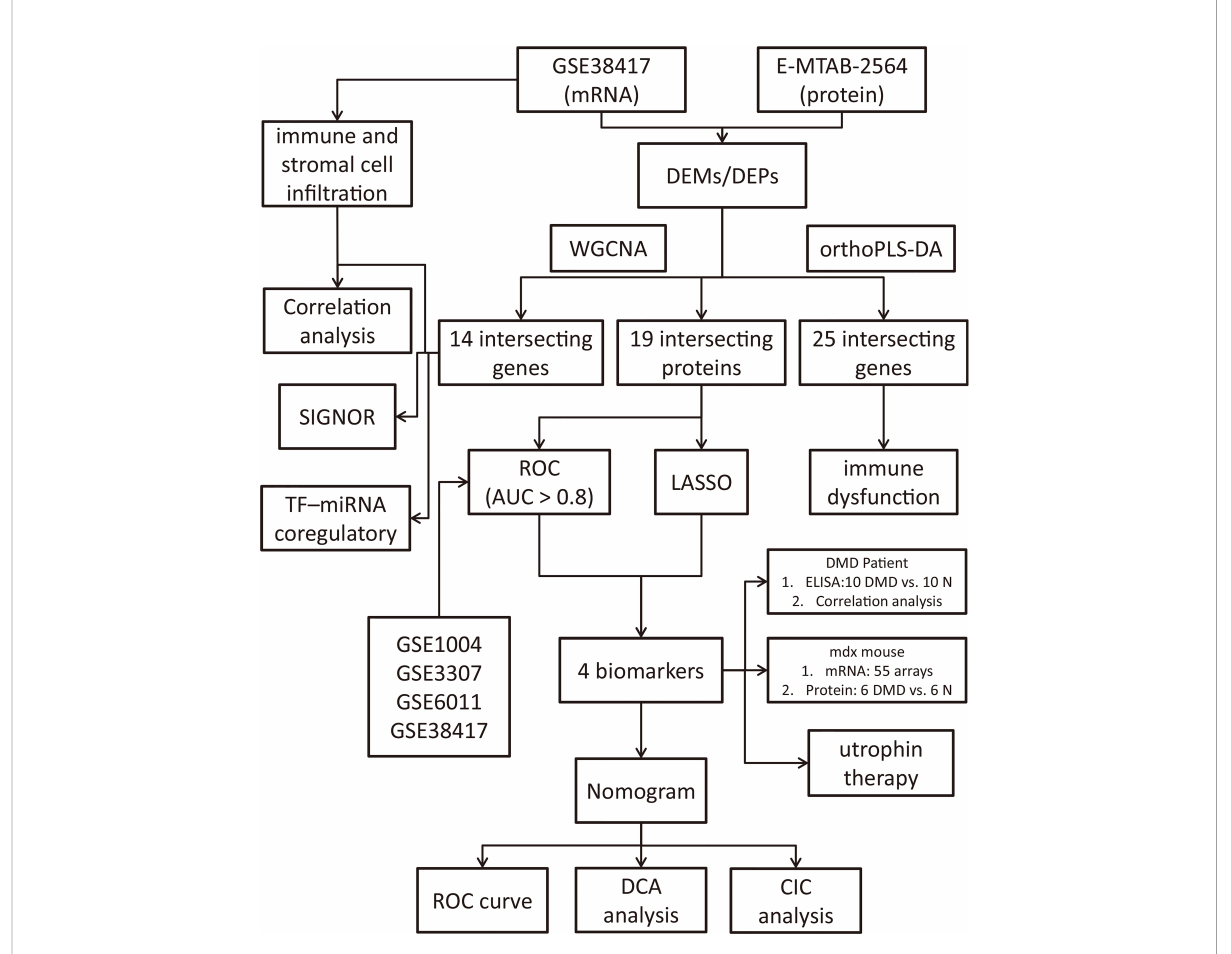
FIGURE 1 Flowchart of the study